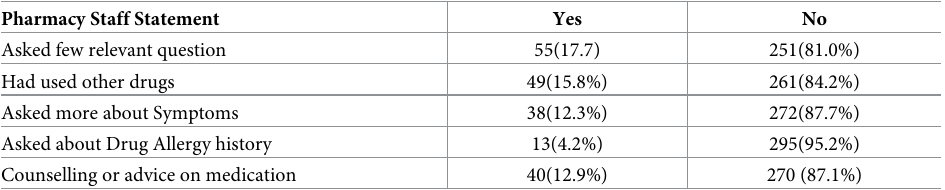
Table 4. Questions and advice from the pharmacy staff to the simulated patient at the pharmacies in which the antibiotic was